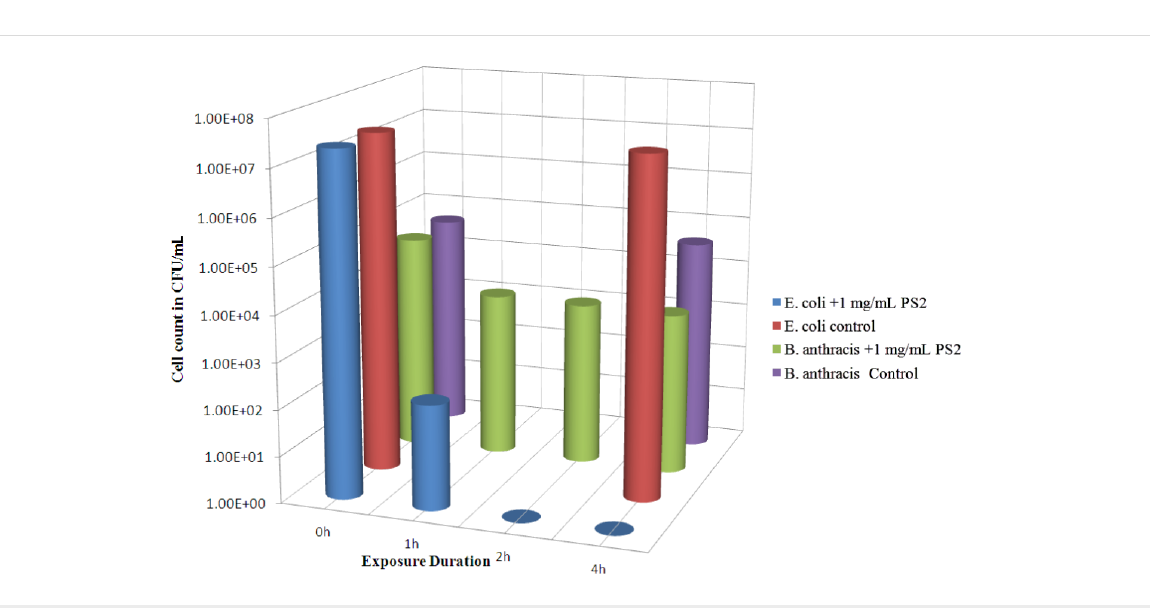
Figure 2: Time dependent bactericidal activity of CuO nanorods (PS2) at a dose of 1 mg/mL against B. anthracis vegetative cells and E. coli cells in saline